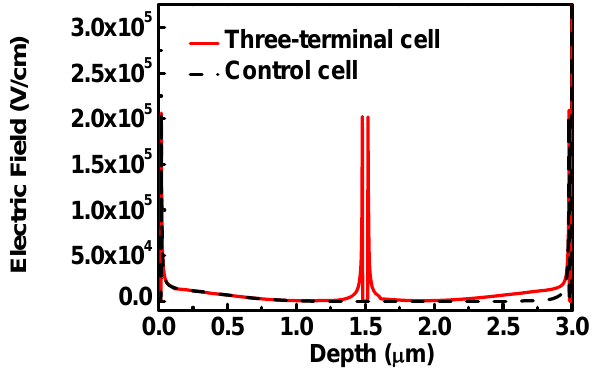
Figure 4. The magnitude of the electric field as a function of the depth. The electric field is widely boosted for the p/i